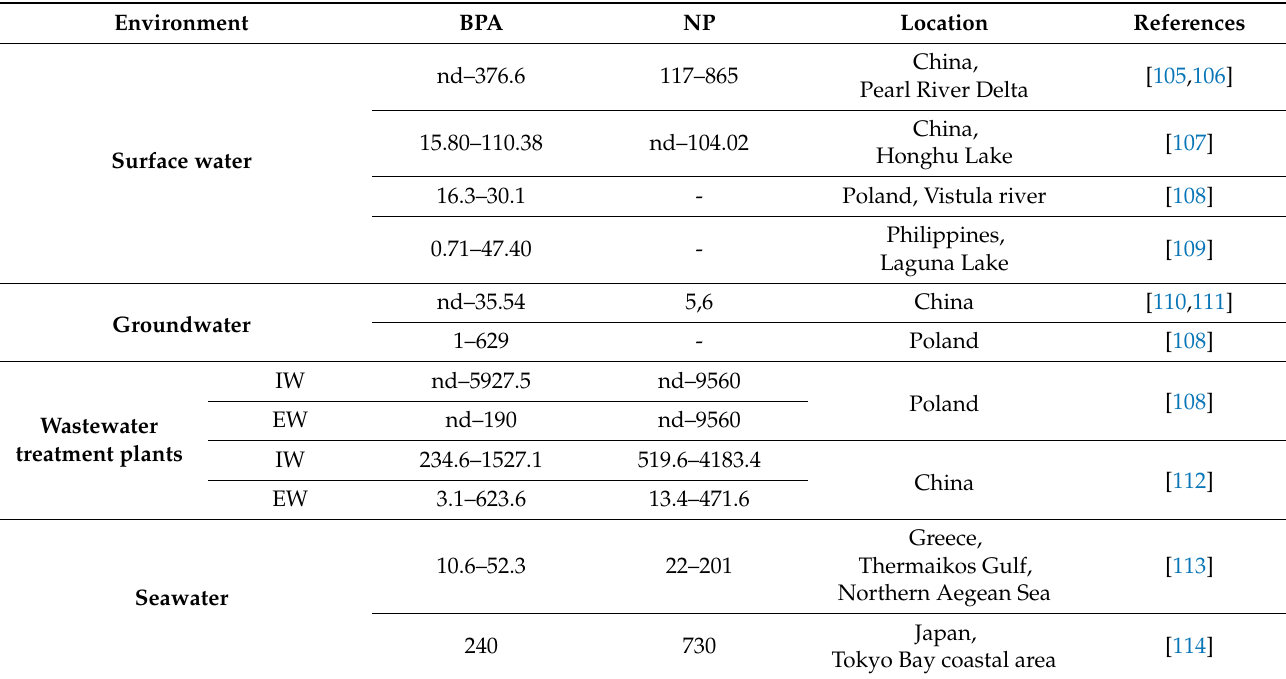
Table 1. The Bisphenol A (BPA) and nonylphenol (NP) concentrations in aquatic